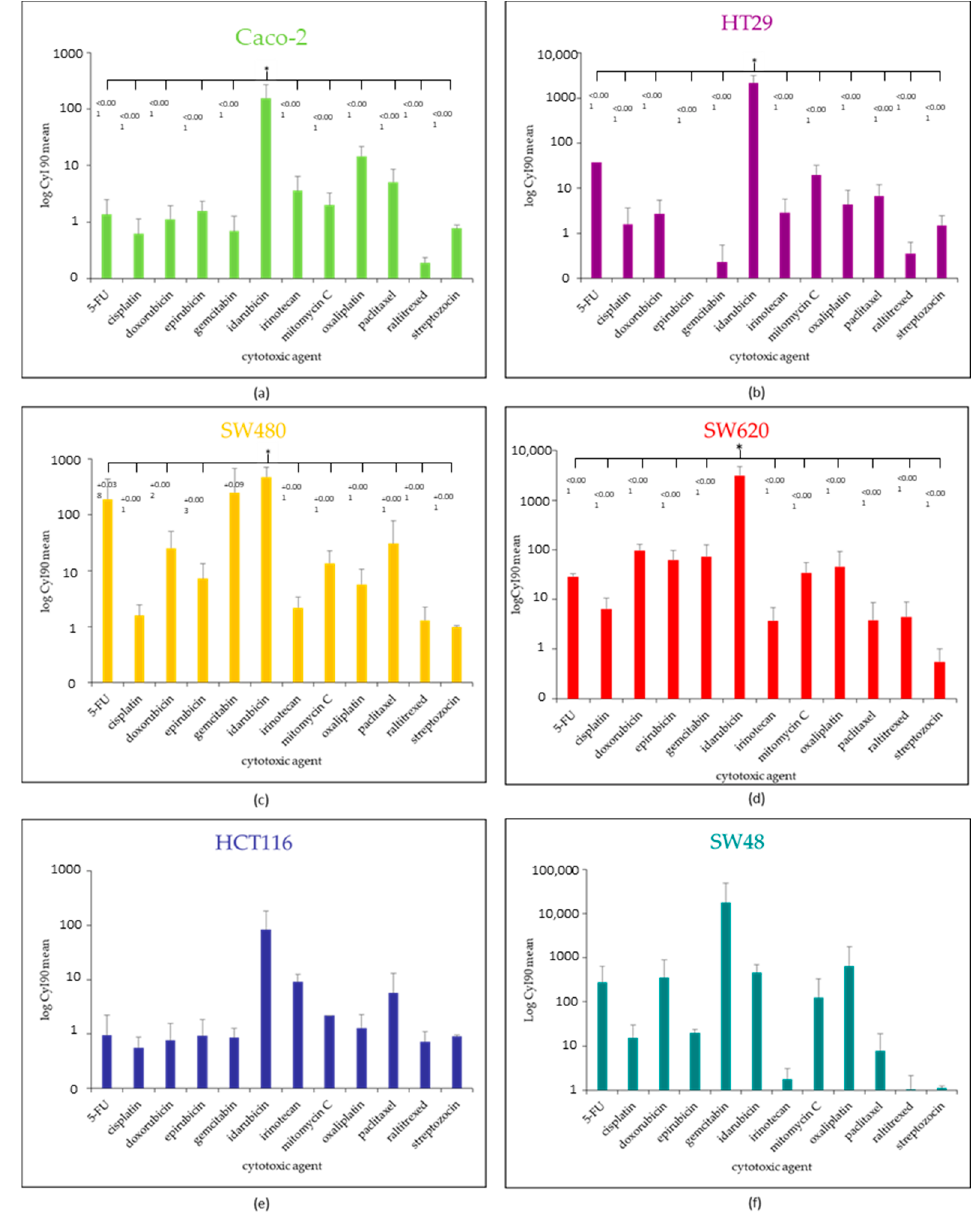
Figure 8. Bar plot representation of the cytotoxic indexes (mean ± standard deviation) for the 6 col- orectal cancer cell lines: Caco-2 ( a ), HT29 ( b ), SW480 ( c ), SW620 ( d ), HCT116 ( e ), SW48 ( f ). The sig- nificant p -values of the post-hoc tests (LSD Fisher) were reported for cell lines with significant one- way ANOVA ( p < 0.05).